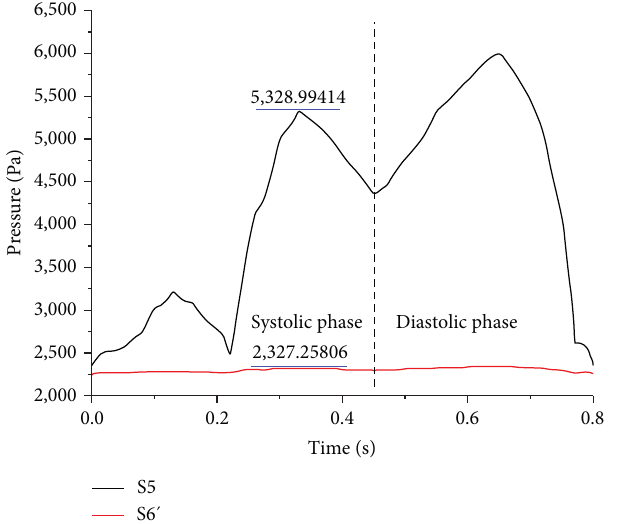
F IGURE 7: Maximum pressures at both ends of the stenosis.